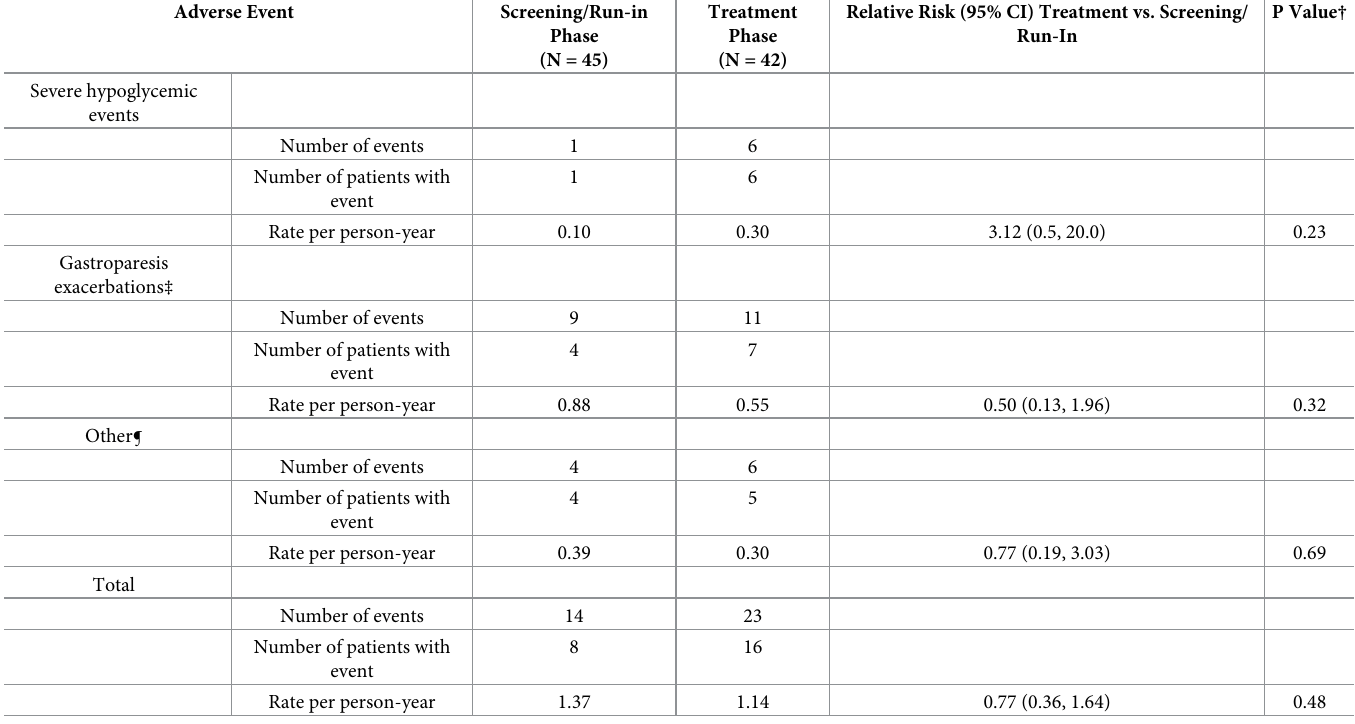
Table 3. Serious adverse